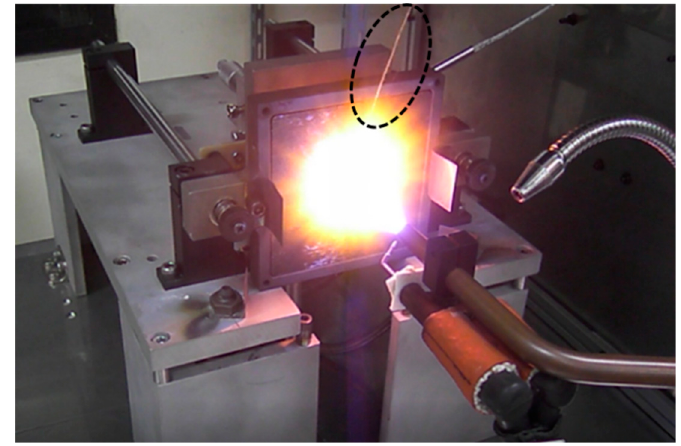
Figure 7. Surface particle changes of 3D C–C composite.